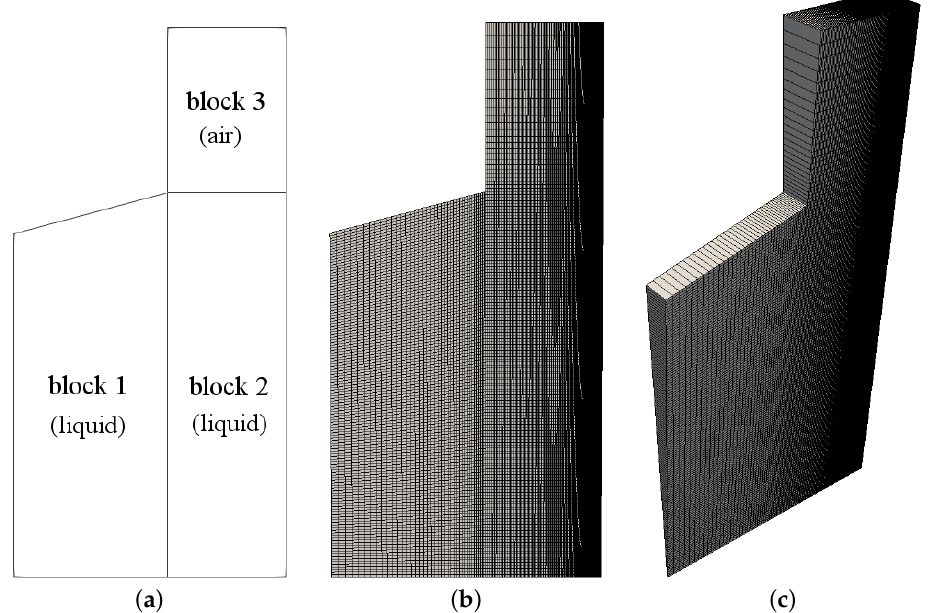
Figure 4. Mesh employed in the numerical calculations of the gravure cell printing process: ( a ) the blocks based on which the domain and the mesh have been created, ( b ) front view, and ( c ) perspective view of the axisymmetric wedge domain.